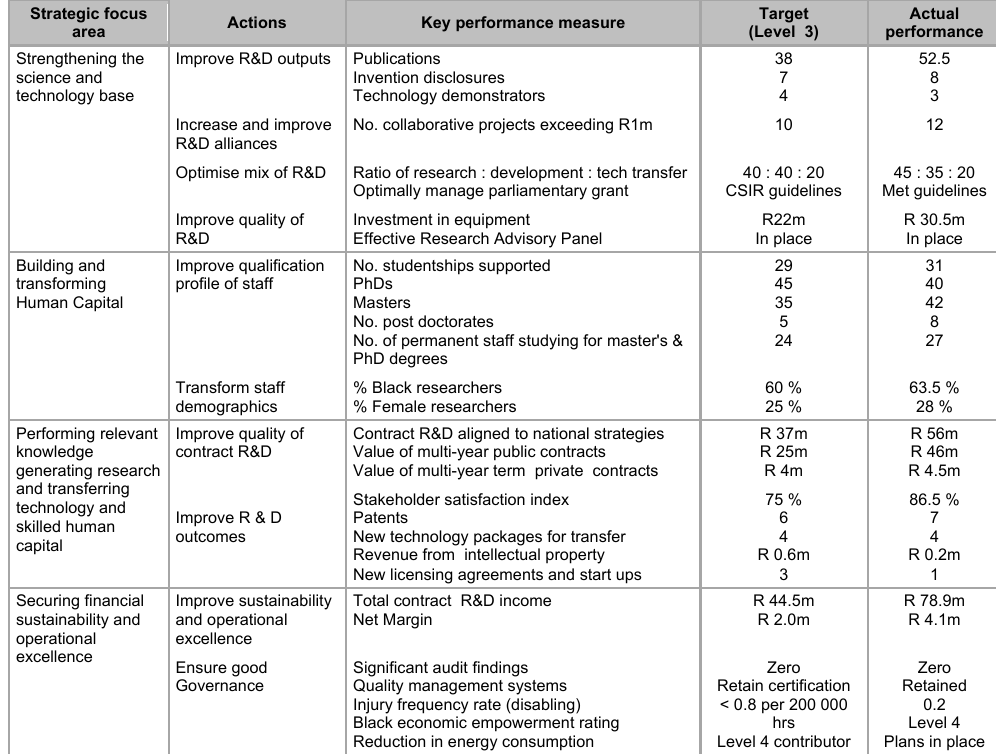
Actual versus planned performance for